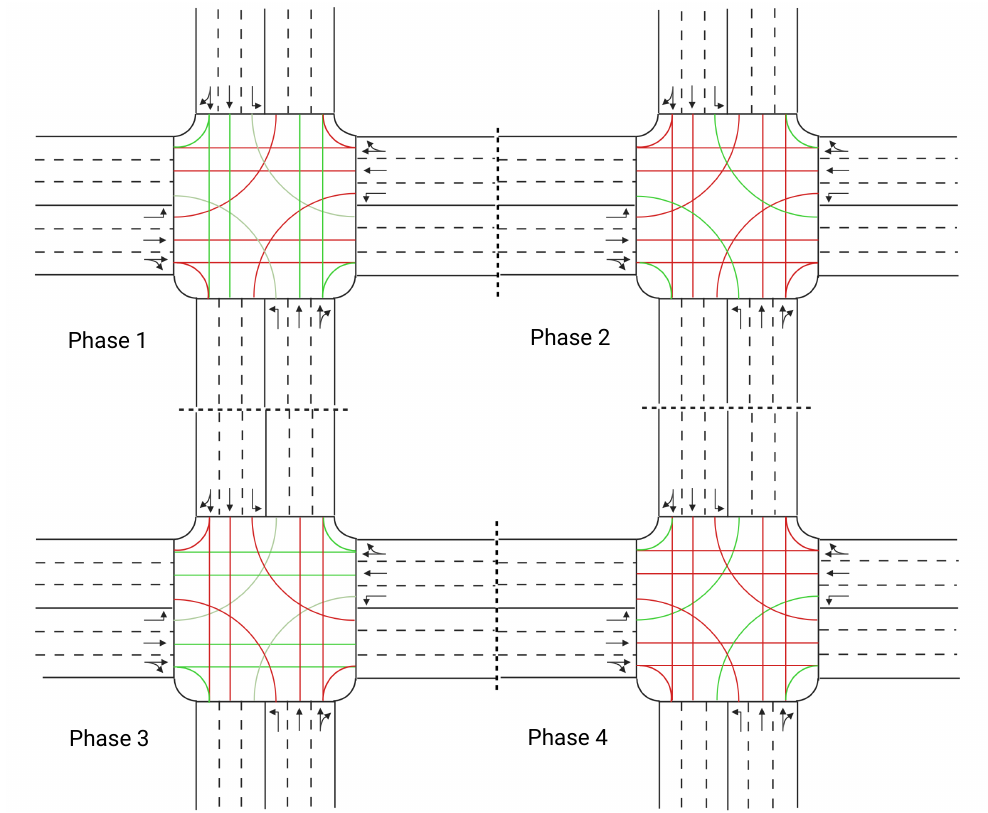
Figure 4. A typical signal cycle with four